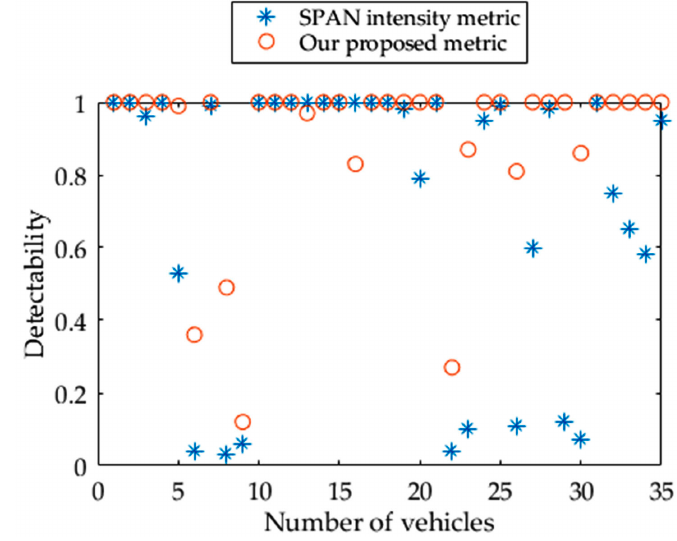
Figure 9. Comparison of detectability between SPAN intensity metric and our proposed metric.